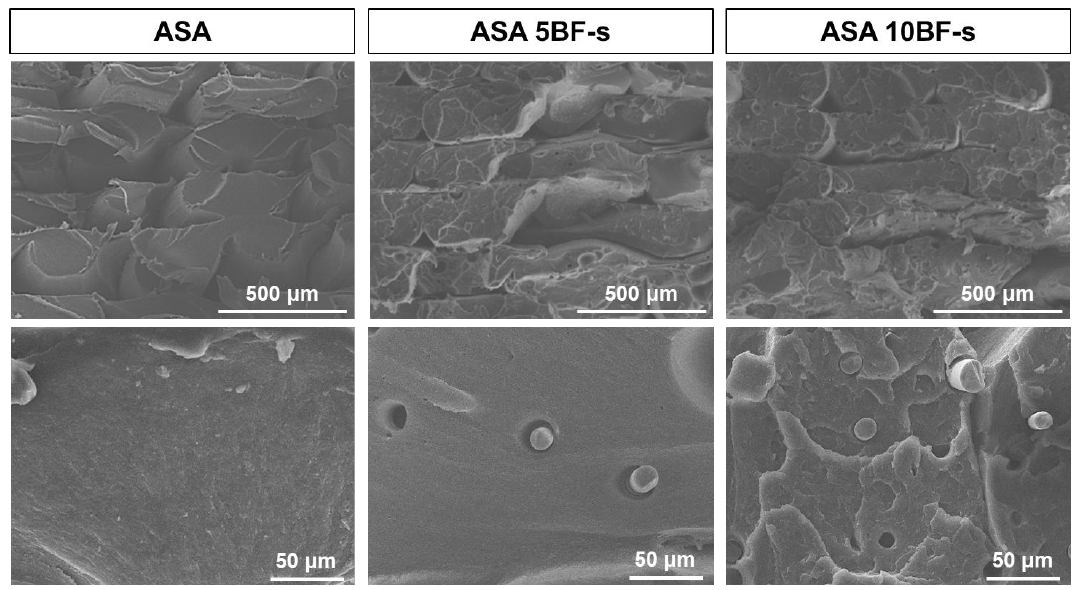
Figure 6. SEM images of fracture surface after tensile testing of ASA and ASA composites manufactured by FFF.